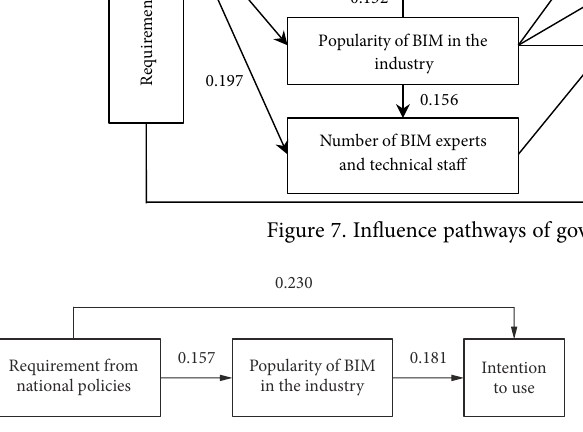
Figure 8. Influence pathways of BIM